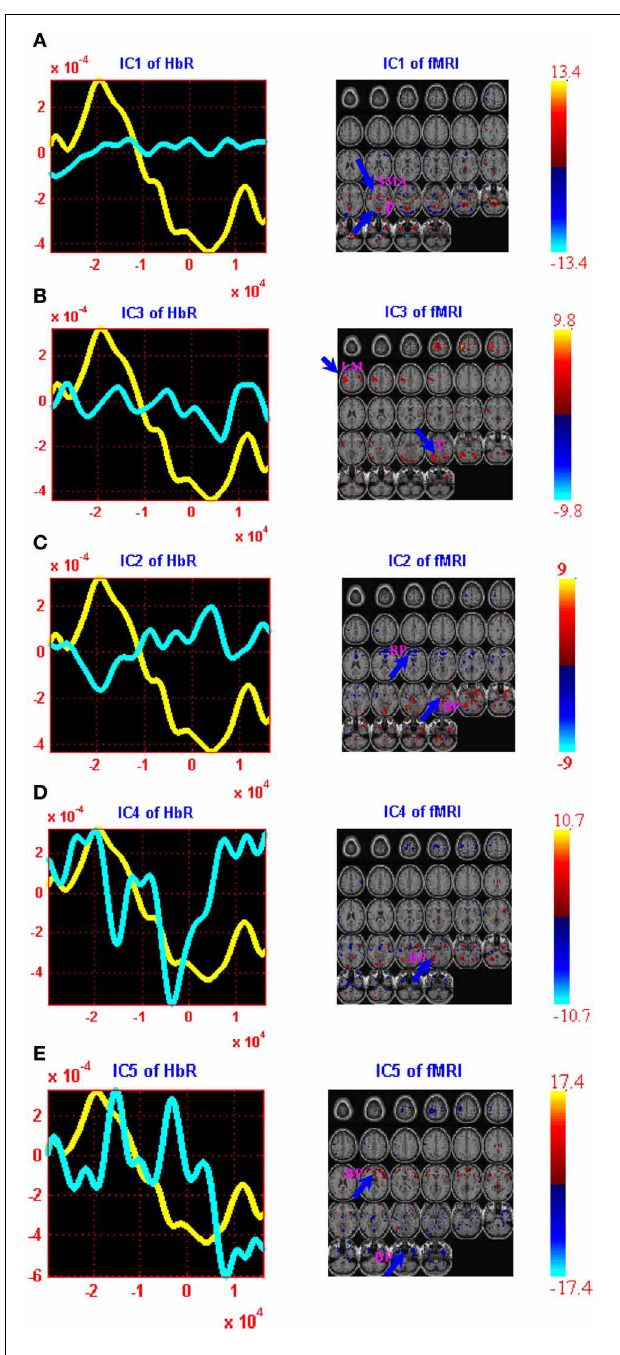
FIGURE 3 | jICA decomposition of (cid:2) HbR and fMRI joint data for right finger tapping tasks: two components were found to be significantly correlated with right finger tapping task (ICs 1 and 3) while three were well-correlated with the physiology and body movement noise (ICs 2, 4, and 5). Each of these components is shown in a separate panel in the figure: IC1 (A) , IC3 (B) , IC2 (C) , IC4 (D) and IC5 (E) . The fMRI maps are thresholded at | Z | > 1 . 5 for display purposes. The averaged event-related HbR time course is shown in yellow (same for all figures) and the (cid:2) HbR component is plotted in cyan. Positive (orange) and negative (blue) Z -values are shown in the image. The axes (bottom) illustrate the time scale, in ms, whereas the scale (left) records chromophore concentrations in μ M for